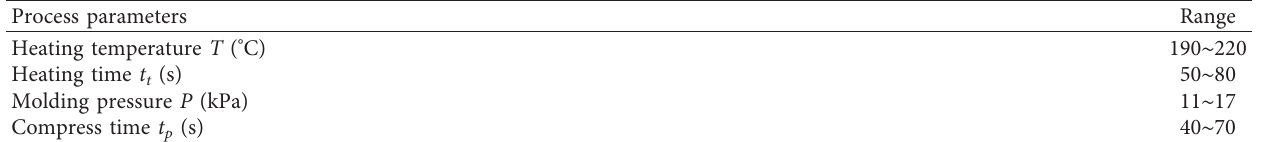
Figure 25: Trend of maximum thinning rate with process parameters. (a) Trend of shrinkage rate with heating temperature. (b) Trend of shrinkage rate with heating time. (c) Trend of shrinkage rate with molding pressure. (d) Trend of shrinkage rate with dwell time. Table 8: Value range process parameters.